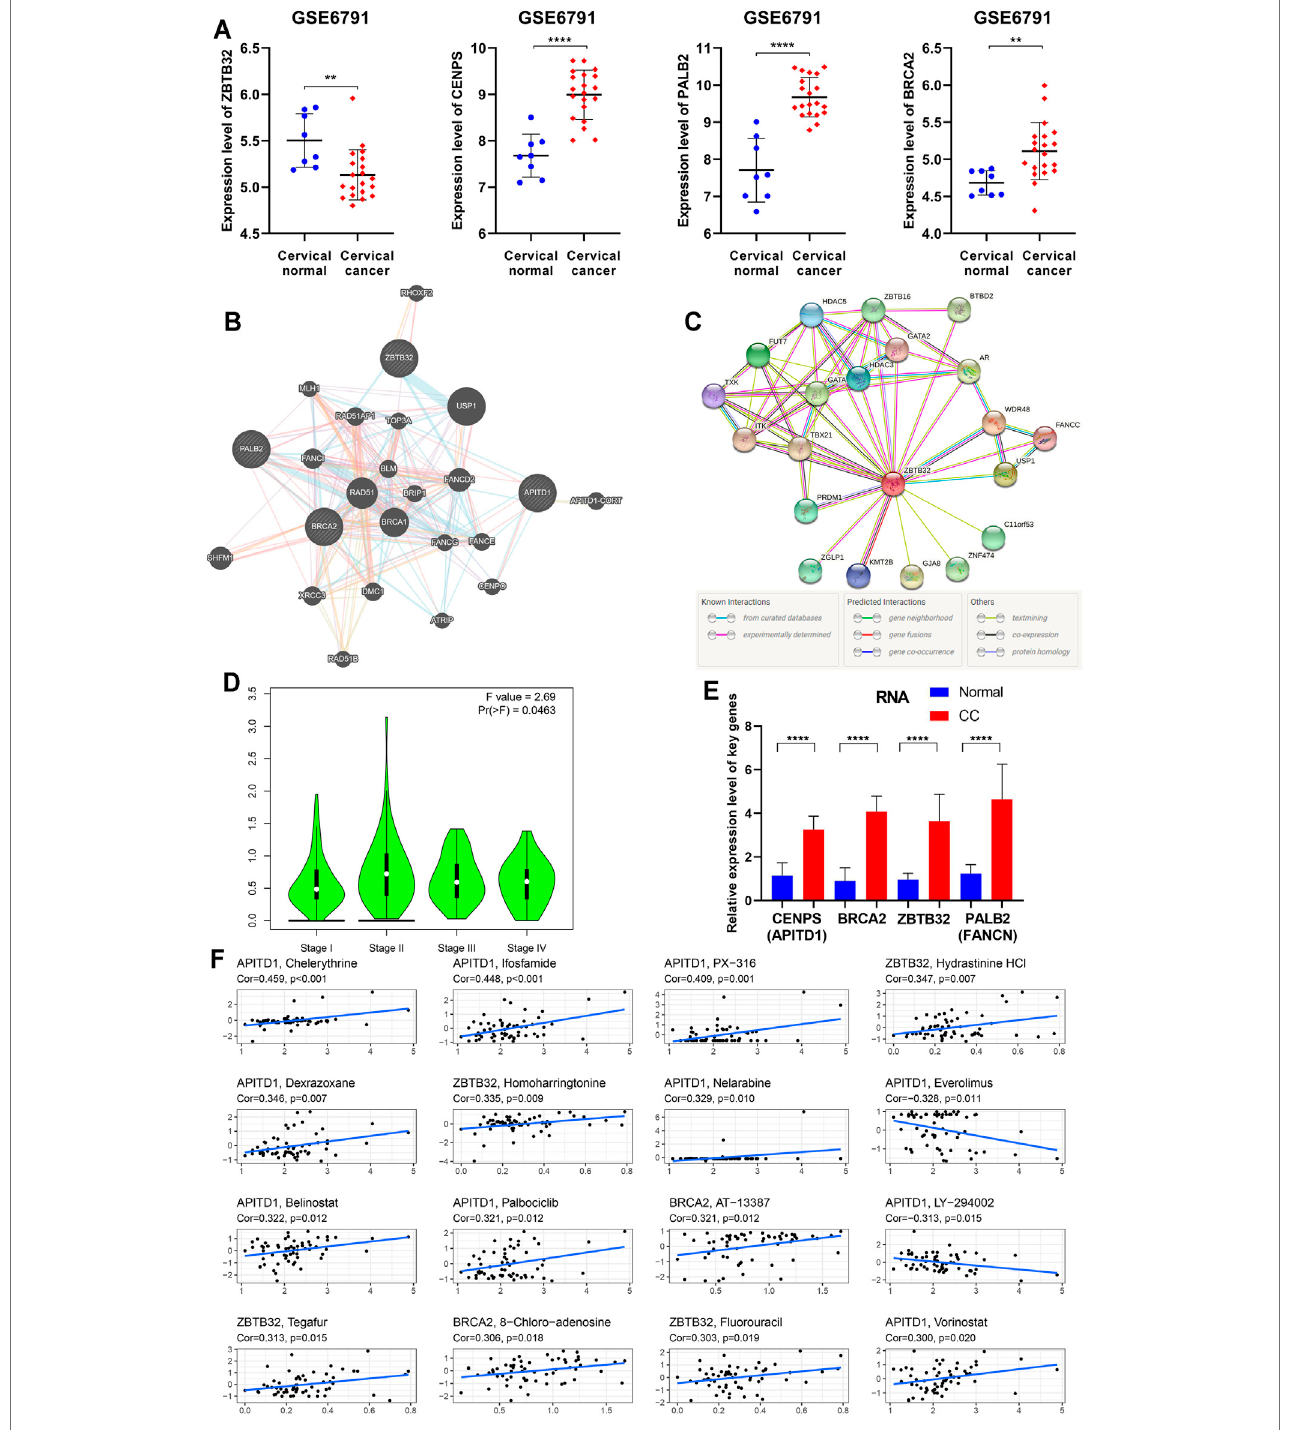
FIGURE 7 | Further bioinformation analyses and validation of the four essential FARGs related to CC prognosis. (A) The expression pattern of ZBTB32 , PALB2 , CENPS, and BRCA2 between CC patients and normal control at RNA level from GSE6791. (B) The PPI network showed the four essential FARGs protein action pattern and associations. (C) The PPI network of ZBTB32 . (D) The violin plot showed ZBTB32 mRNA expression in various clinical stages of CC. (E) The mRNA expression and comparison between 19 CC tissues and 22 corresponding normal tissues by qPCR. (F) The scatter diagram showed the association between the four FARGs and drugs, which might provide new clues to uncover potential mechanisms for CC prognosis.